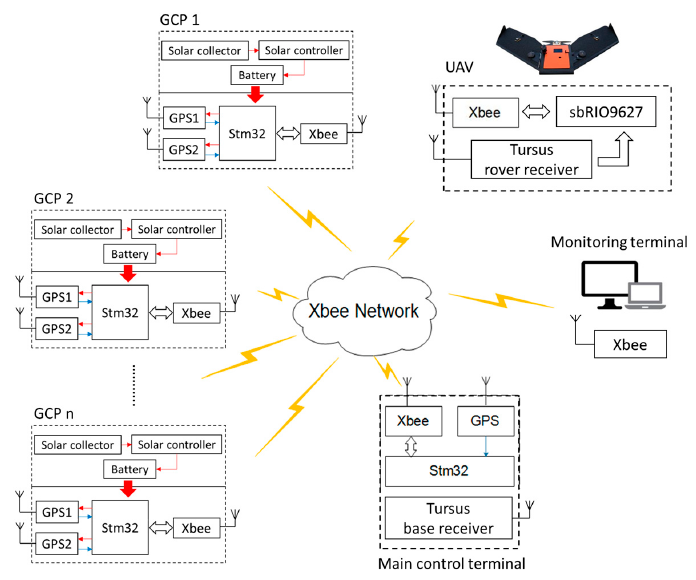
Figure 1. Overall schematic diagram of the wireless system network.